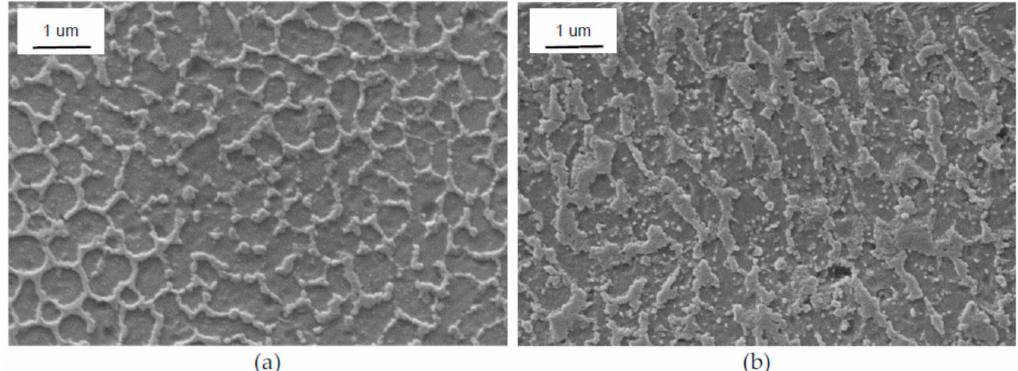
Figure 3. High magnification SEM views of the as-built microstructure detected in cold platform ( a ) and hot platform ( b ) samples. The Si network surrounding the α -Al cells is the lighter phase, discrete intracellular Si precipitates are observed in panel b as spheroidal-shaped particles located inside the α -Al cells.